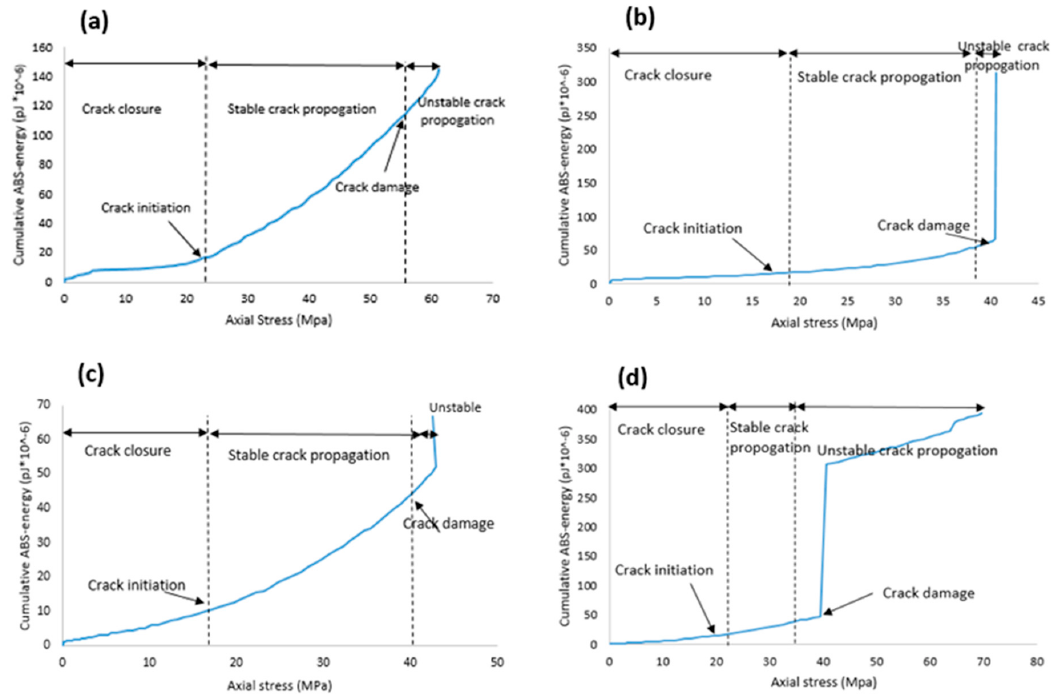
Figure 12. Cumulative absolute energy with axial stress for ( a ) dry specimen; ( b ) 10% NaCl; ( c ) 20% NaCl-saturated specimen; ( d ) 25% NaCl-saturated specimen.